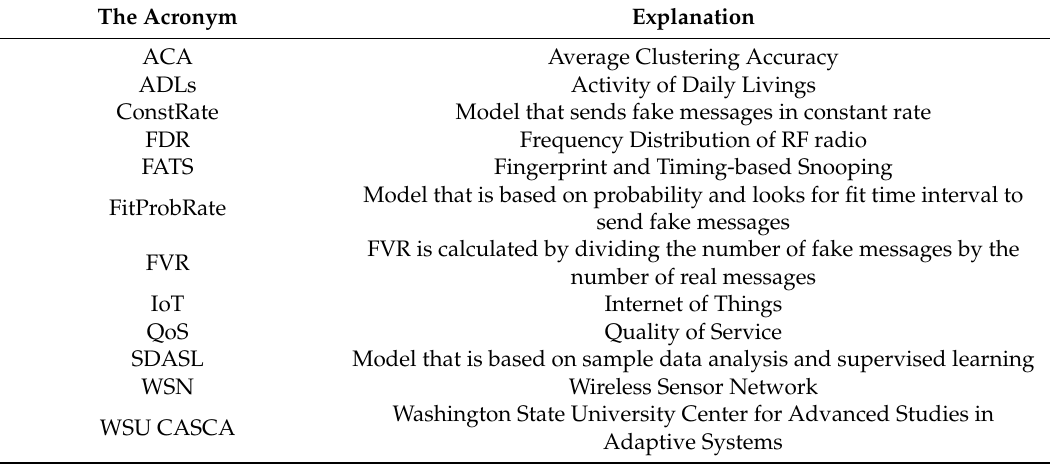
Table A1. List of Acronyms and